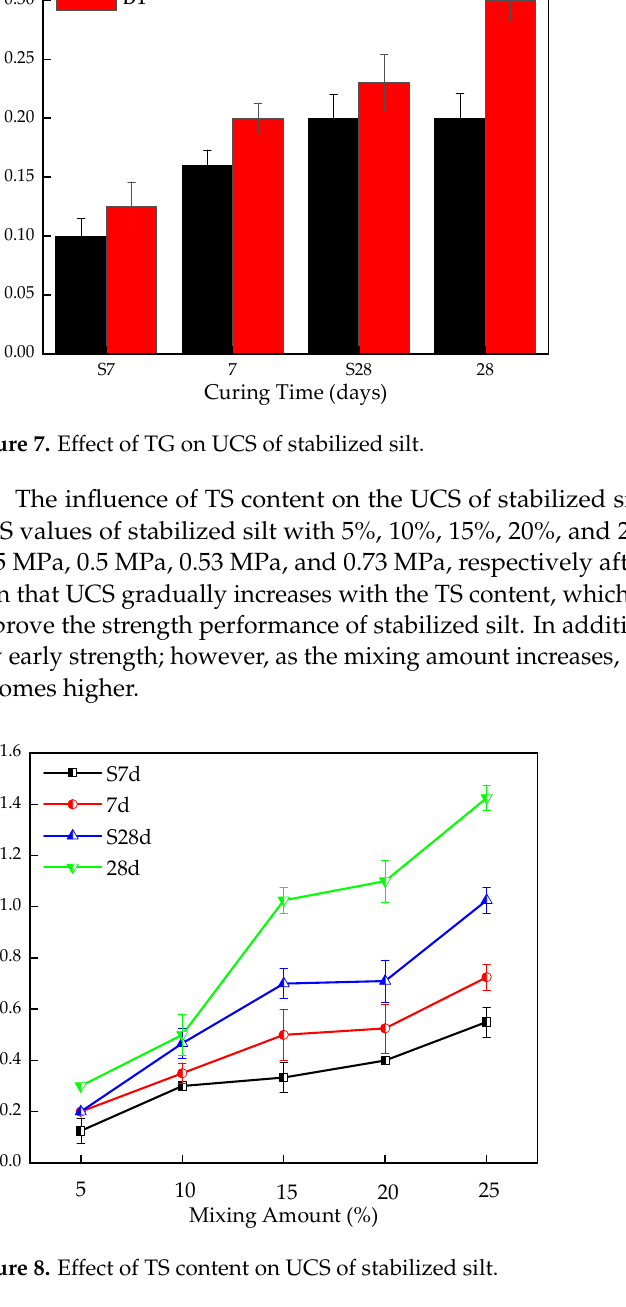
Figure 8. Effect of TS content on UCS of stabilized